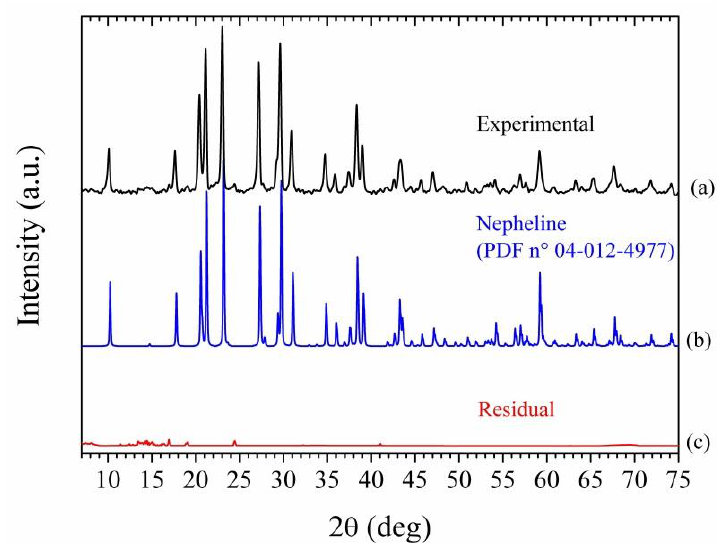
Figure 6. X-ray powder diffraction patterns of (a) GeoEpojet20 sample after 24 h at 800 °C; (b) nepheline (PDF n° 04-012-4977); and (c)